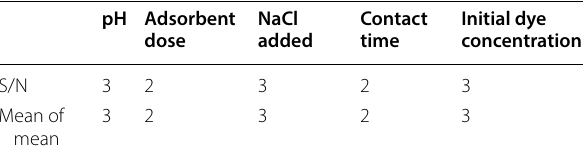
Table 3 Optimum conditions for each factor to simultaneous removal of MG, RhB and